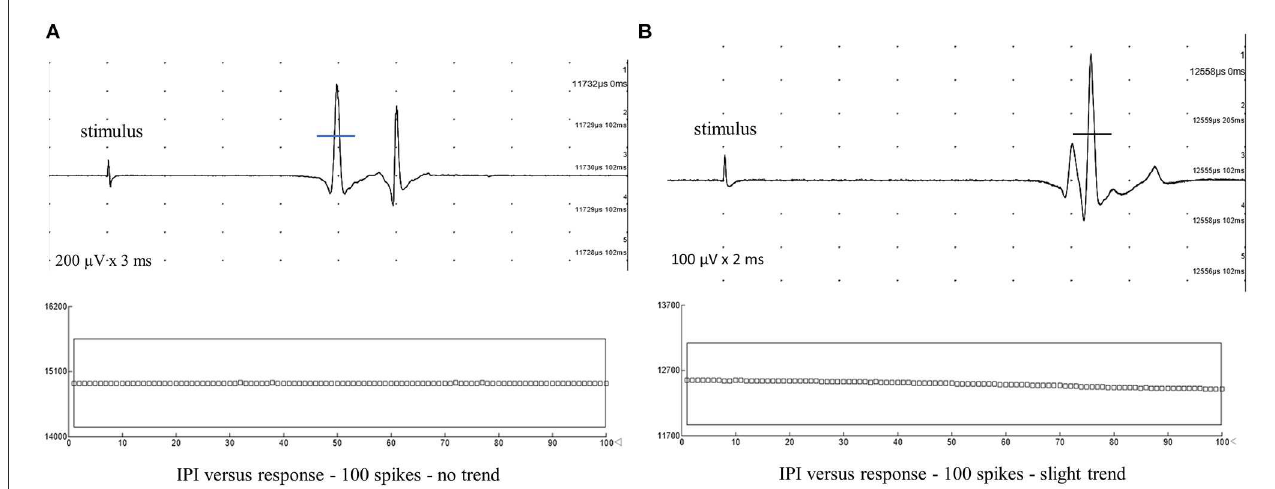
FIGURE3 Typical muscle fiber action potentials after intramuscular monopolar needle electrode stimulation were recorded from the tibialis anterior muscle with five superimposed traces. The mean consecutive difference of < 5 µ s after 100 spikes confidently indicates direct muscle fiber stimulation. The latency mark is made in the middle of the depolarizing negative line to calculate muscle fiber conduction velocity (MFCV). (A) Latency = 11.73ms. MFCV = 4.24 m/s, no trend. (B) Latency = 12.42ms. MFCV = 4.03 m/s. Due to the slight trend in the graph interpotential interval (IPI) or latency vs. response, the MFCV should be calculated to the shortest latency.